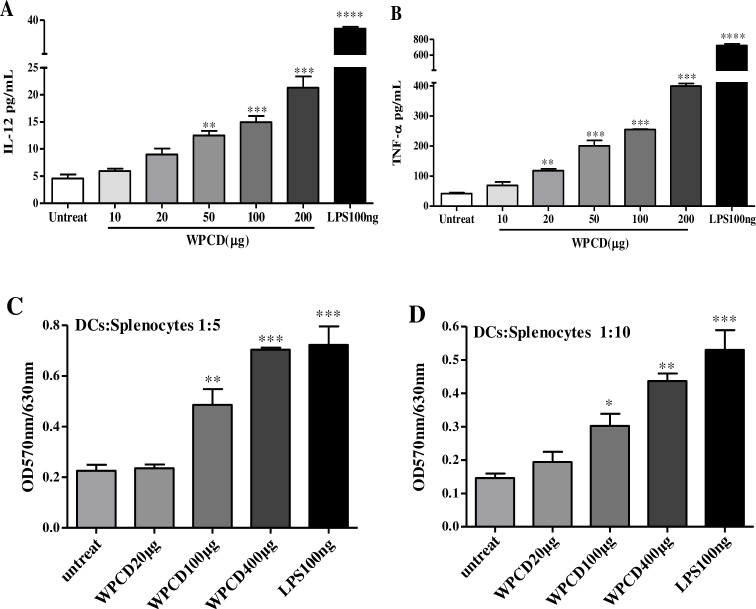
Effects of WPCD on cytokine production and functional activation of DCs in vitro.After DCs were treated with different concentrations of WPCD for 12 h, the supernatant was collected and the productions of IL-12 and TNF-α were detected by ELISA. The concentrations of IL-12 (A) and TNF-α (B) were shown. An allogenic T cell proliferation of WPCD-treated DCs was analyzed by MLR. Allogenic T cells were co-cultured for 3 days at the indicated ratio with DCs which had been cultured for 12 h in triplicate (C and D). MTT was added into the cultures for final 4-h treatment and the T cell proliferation was then determined by ELISA reader. Data represent mean ±SD (n = 3) from 3 independent experiments.*P < 0.05, ** P < 0.01, *** P < 0.001 compared with the untreated DCs group.